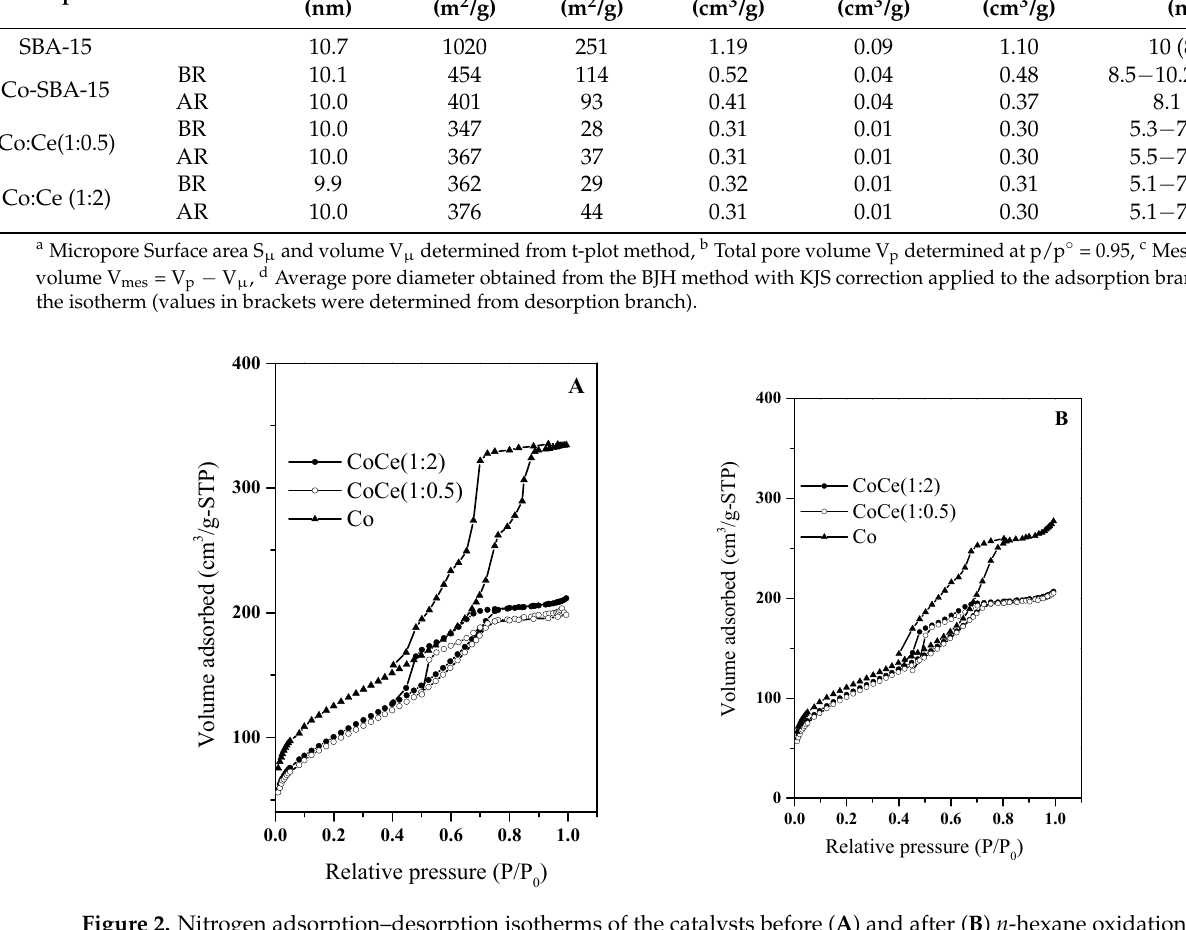
determined at p/p° = 0.95, c Mesopore volume V mes = V p − V µ , d Average pore diameter obtained